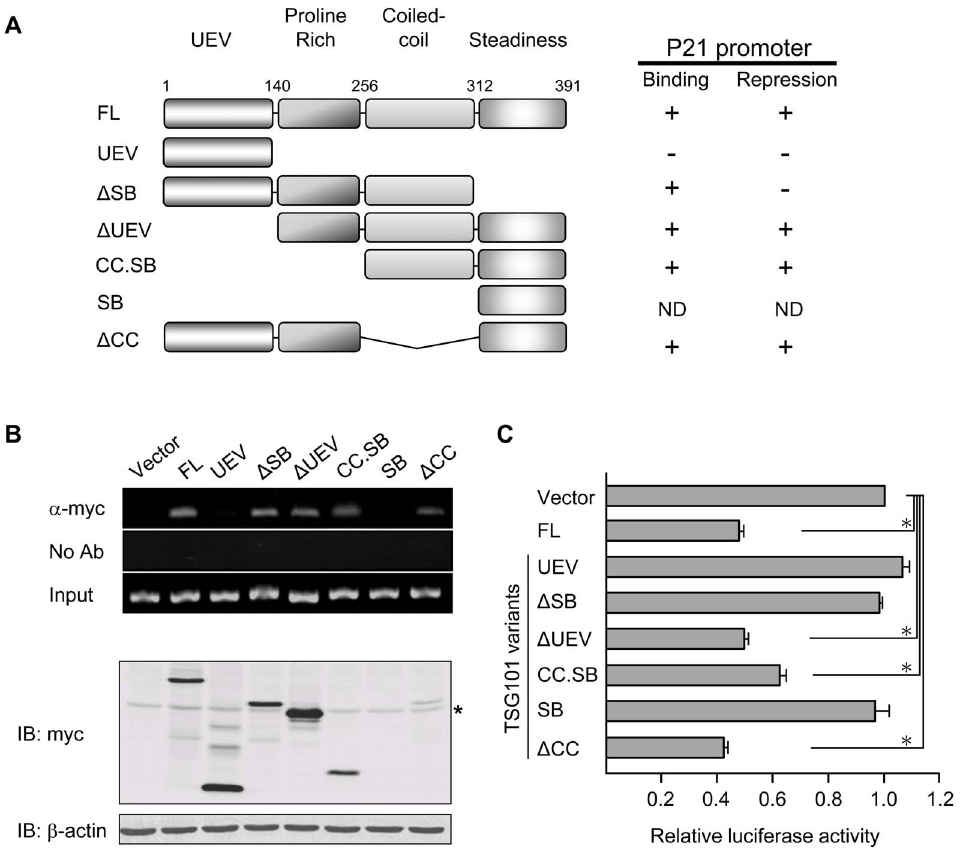
Figure 4. Specific TSG101 domains are required for p21 promoter binding and repression. (A) Left, TSG101 contains 391 amino acids with the four indicated domains. Constructs expressing myc-tagged full-length or truncated forms of TSG101 are illustrated. Right, p21 promoter binding and repression by these TSG101 variants are summarized. ND, not determined. (B) Binding of full-length TSG101 and its truncated forms to the p21 promoter was examined by chromatin immunoprecipitation. DNA fragments, which co-precipitated with anti-myc antibody, were PCR-amplified using the primer set ‘‘d’’, as shown in Figure 3A. Expression of TSG101 variants is shown by the Western blot in the bottom panel. Asterisk indicates the position of non-specific bands. (C) p21 promoter activity was assessed in Saos-2-2 cells expressing different forms of TSG101. Empty vector sample was included as control, and its promoter activity was set as 1. Data presented are the average of five independent experiments (* P , 0.05, Student’s t test).